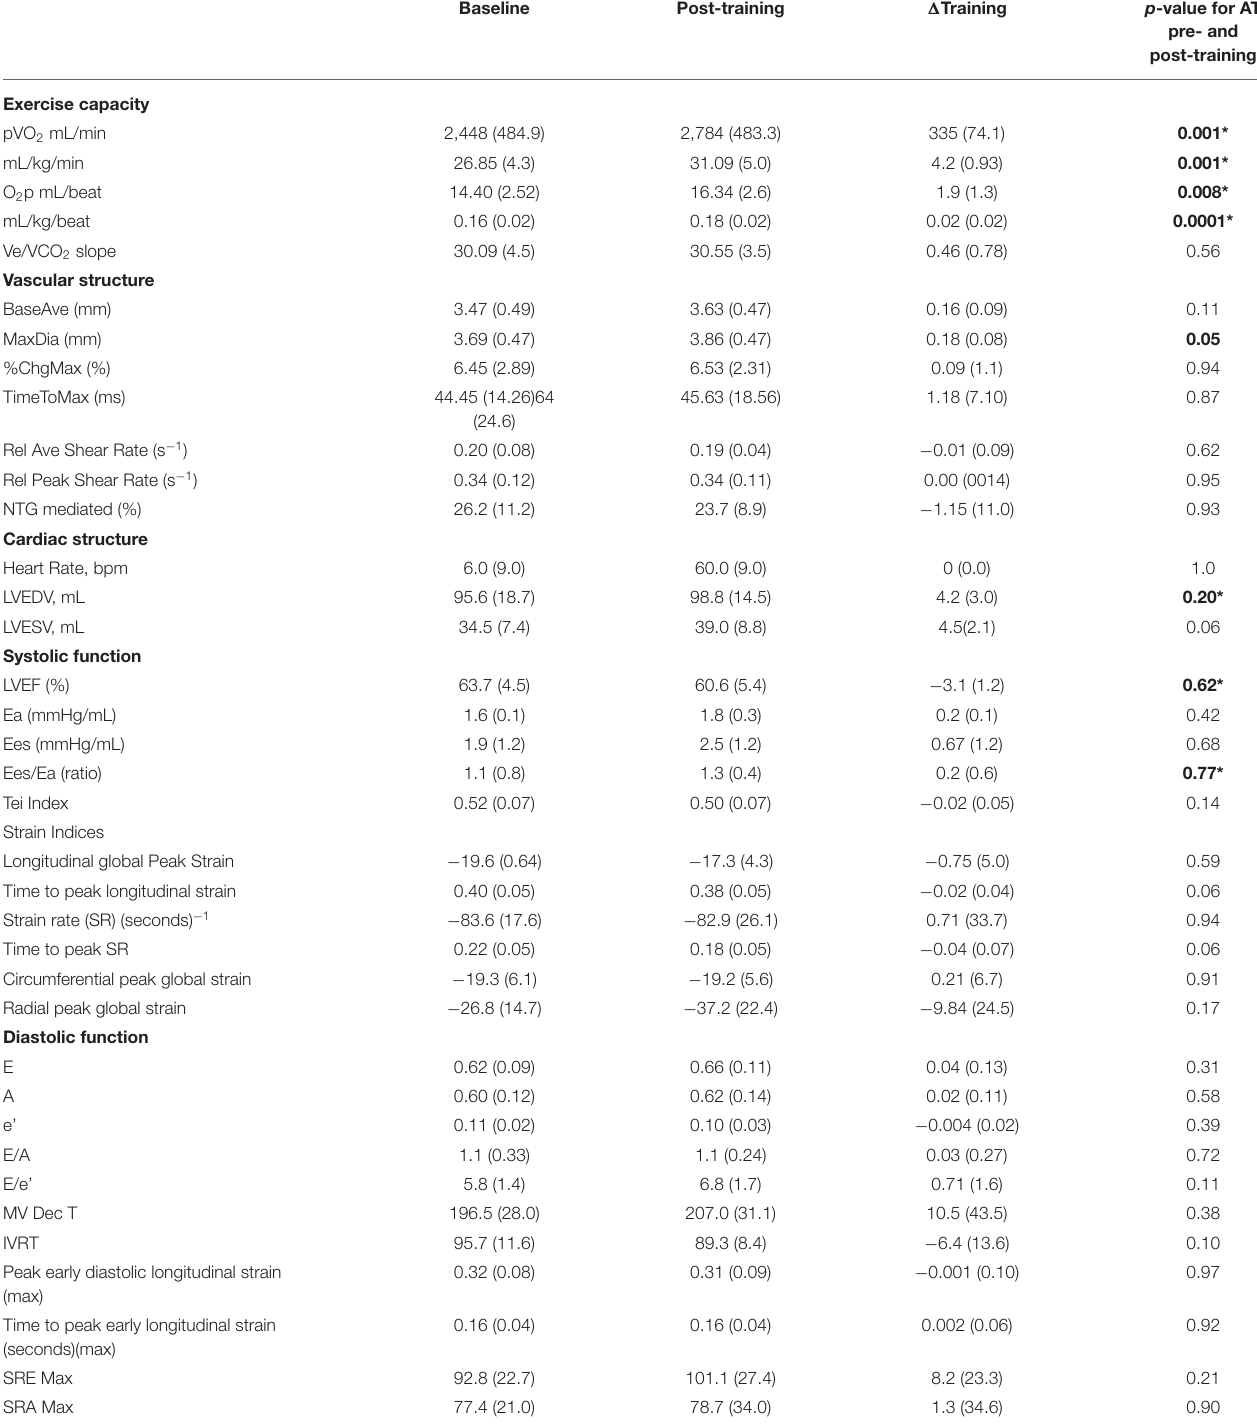
TABLE 2A | AT group pre- and post-training results and AT/RT pre/post-training group comparisons. Baseline Post-training 1 Training p -value for AT